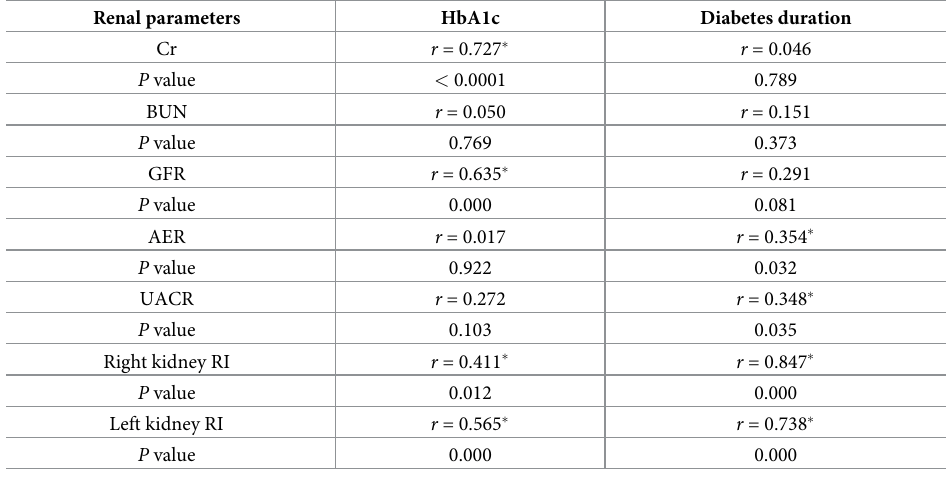
Note: � P < 0.05, Statistically significant BUN, blood urea nitrogen; Cr, creatinine; UACR, urinary albumin/creatinine ratio; AER, albumin excrete rate; GFR, glomerular filtration rate; HbA1c, glycosylated hemoglobinA1c; RI, resistivity index